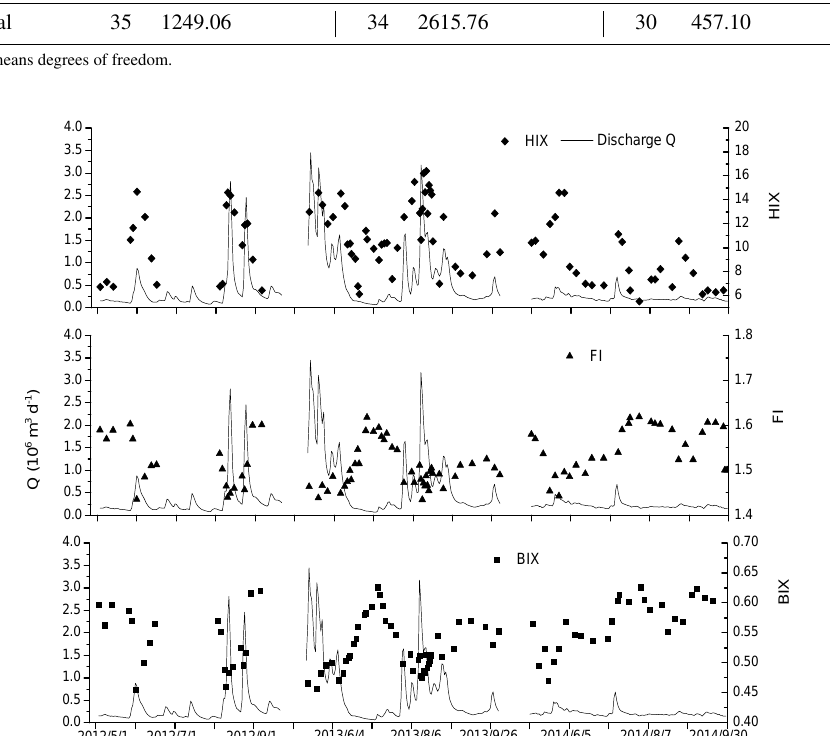
Figure 5. Dynamics of the three spectral indices following discharge ( Q ) during the 2012–2014 sampling period.